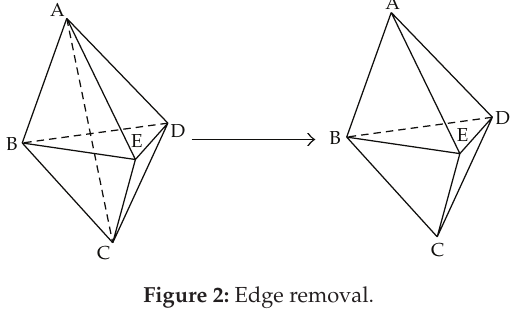
Algorithm 4: Topology optimization algorithm.